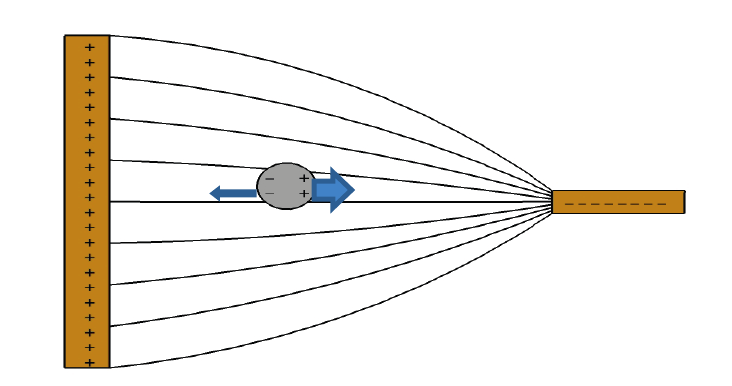
Figure 3. Principle of dielectrophoresis in an inhomogeneous electric field. Cells that are more polarizable than the surrounding medium are attracted towards the high electric field at the smaller